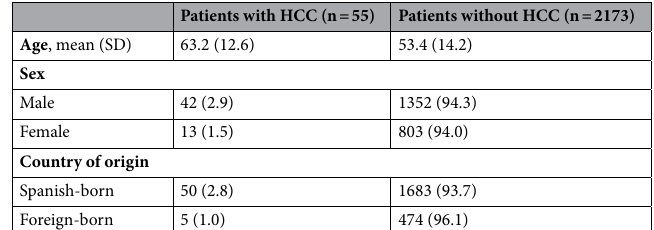
Patients with HCC (n = 55) Patients without HCC (n =